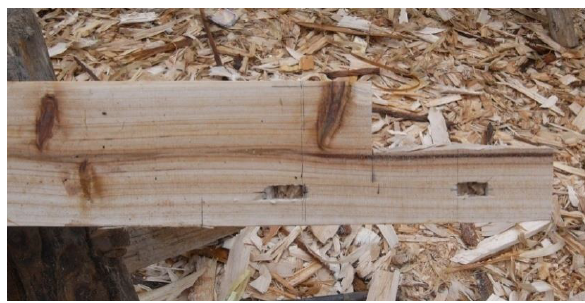
Figure 1 . Green wood with knots used as wooden component